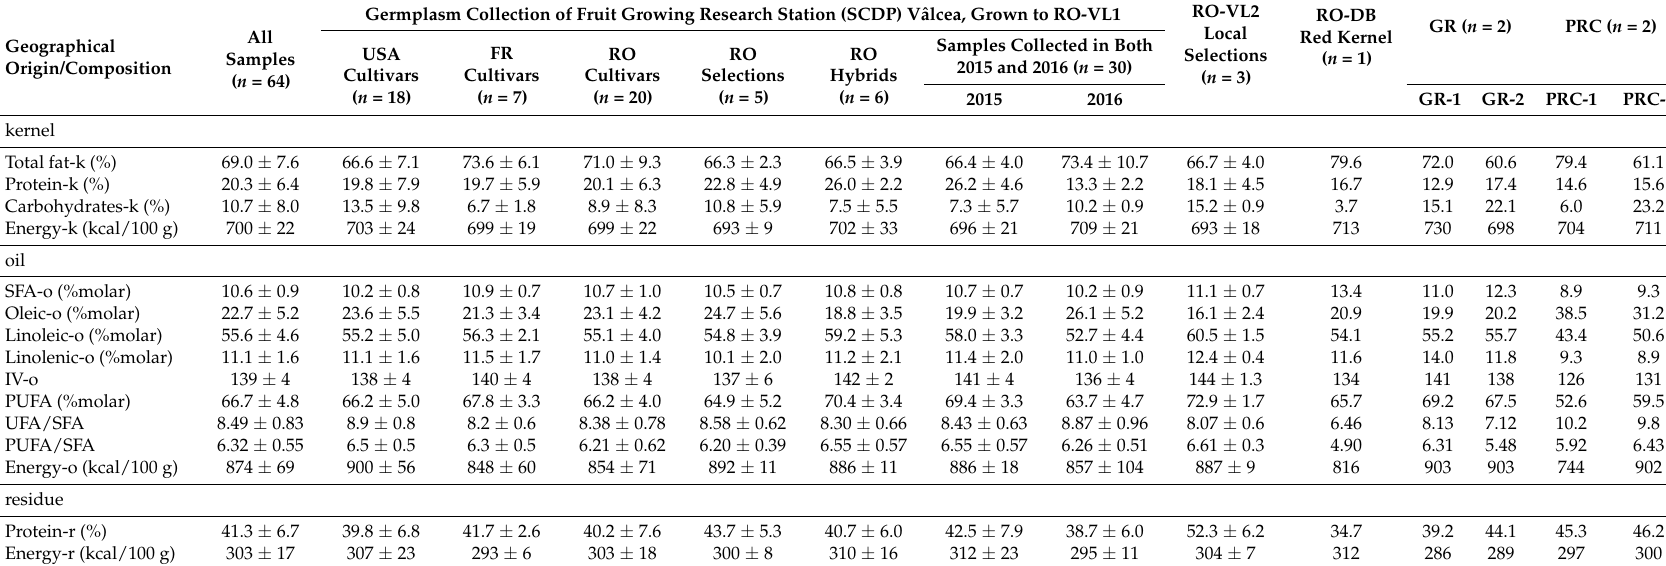
Table 1. Composition of the walnut kernel, oil, and